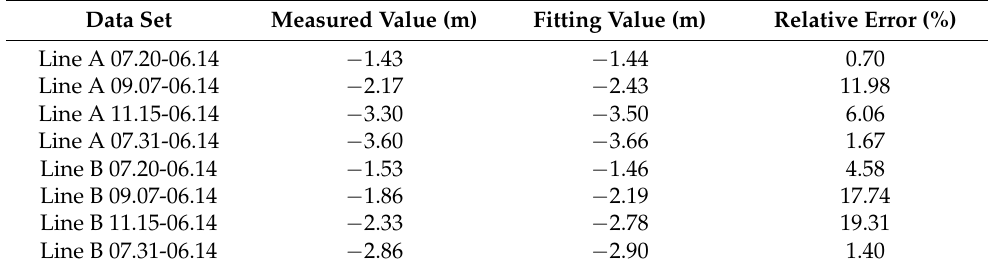
Figure 8. Time series subsidence curve for the main section: ( a ) strike subsidence curve fitting; and ( b ) dip subsidence curve fitting. Table 5. Comparison of maximum subsidence values between measured values and curve fitting. Data Set Measured Value